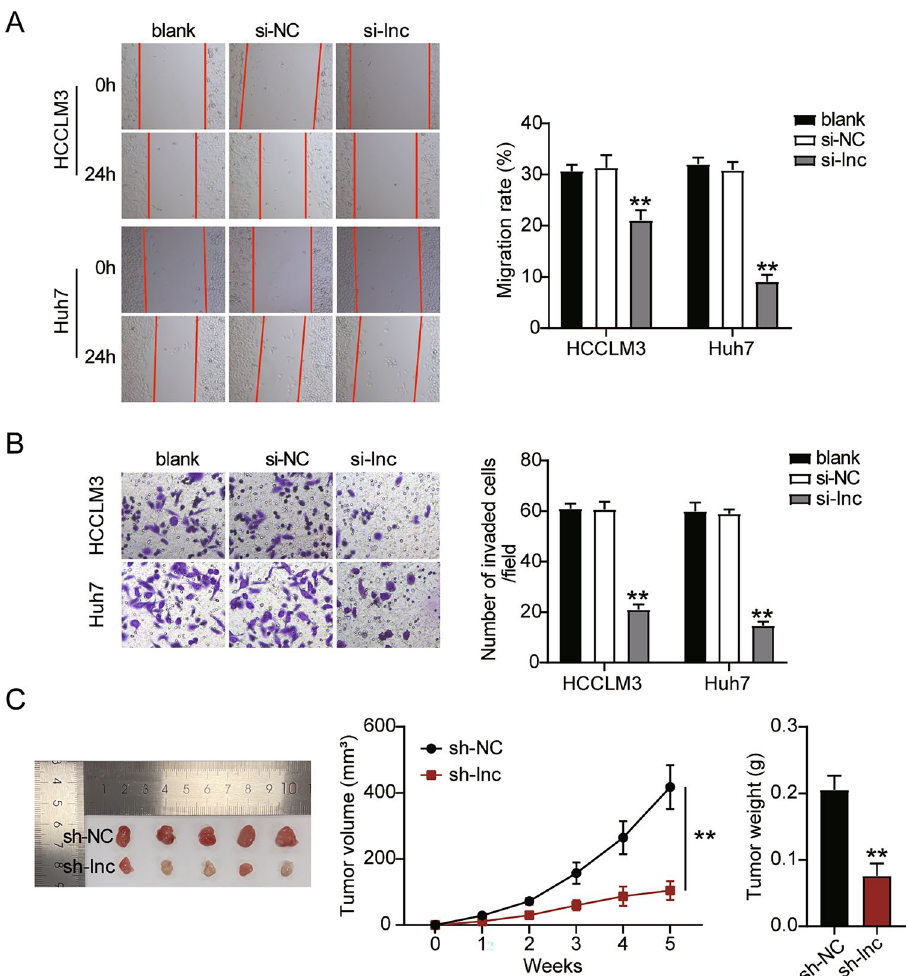
Figure 4. ST8SIA6-AS1 elevated cell migration, invasion and the tumor growth of LIHC cells. ( A ) Cell migration ability detection through wound healing assay. **P < 0.001 compared with blank. NC: negative control; blank: blank control; si-ST8SIA6-AS1: siRNA-ST8SIA6-AS1. ( B ) The transwell assay is used to detect cell invasion. **P < 0.001 compared with blank. NC: negative control; blank: blank control; si-ST8SIA6-AS1: siRNA-ST8SIA6-AS1. ( C ). The tumor volume curve and tumor weight were observed in xenograft Balb/c nude mice model with HCCLM3 cells transfected with sh-ST8SIA6-AS1 in vivo. **P < 0.001 compared with sh-NC. NC: negative control; sh-ST8SIA6-AS1: